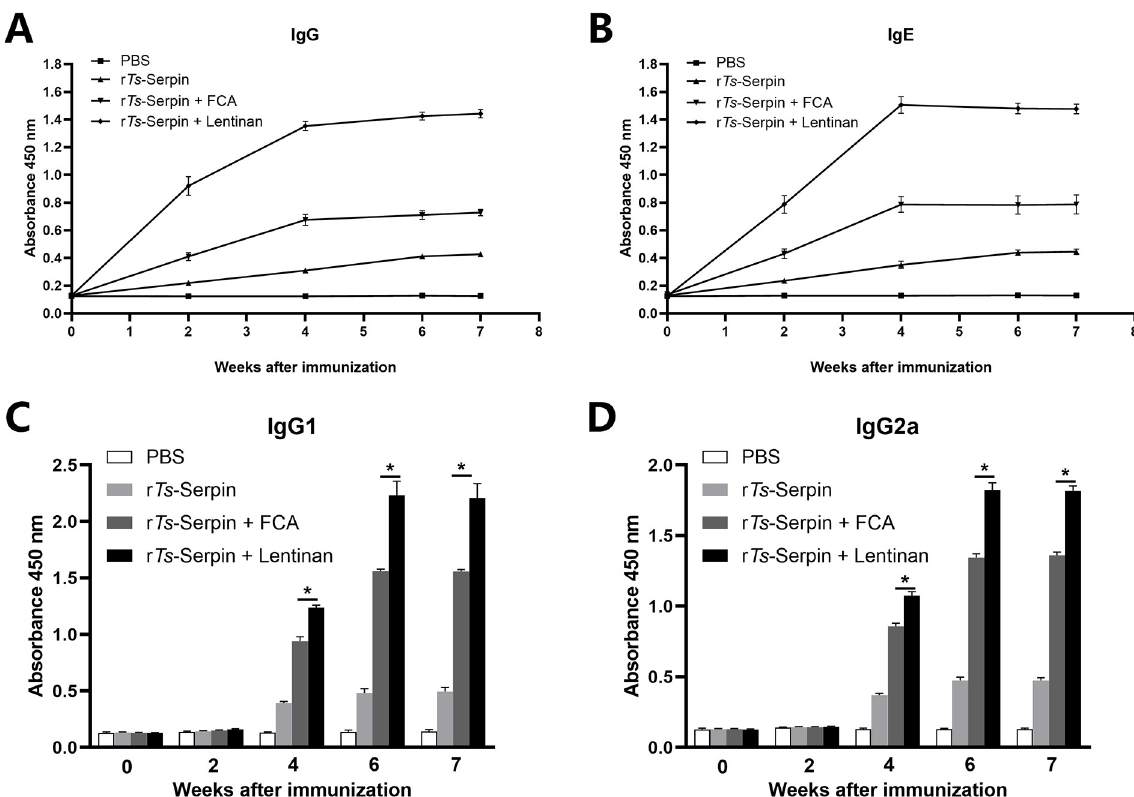
Fig 2. Analysis of humoral immune responses. (A) The levels of anti-r Ts -serpin IgG in the sera of immunized mice or control mice were measured by ELISA. (B) The levels of specific IgE r Ts -serpin in the sera of immunized mice were measured. (C) The IgG1 subclass responses against r Ts -serpin were detected at different time points. (D) The IgG2a subclass responses against r Ts -serpin were detected at different time points. The values shown for each group are the mean + SD of the antibody levels (n = 10) from three individual experiments � p < 0.05 as indicated by the line (one-way ANOVA with Tukey’s